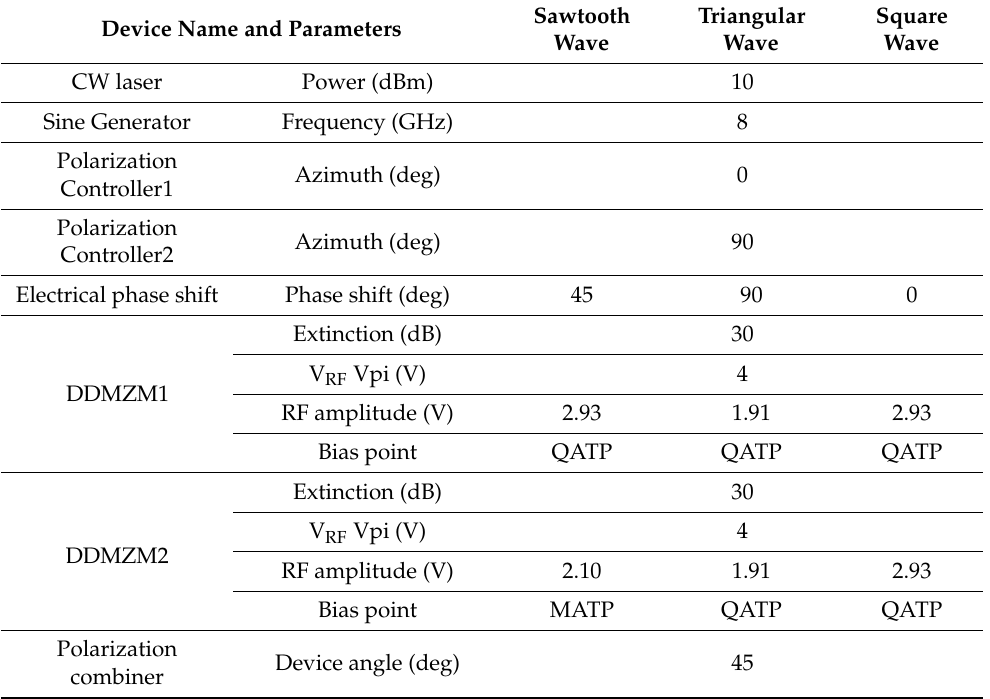
Table 1. Device parameter table used in the